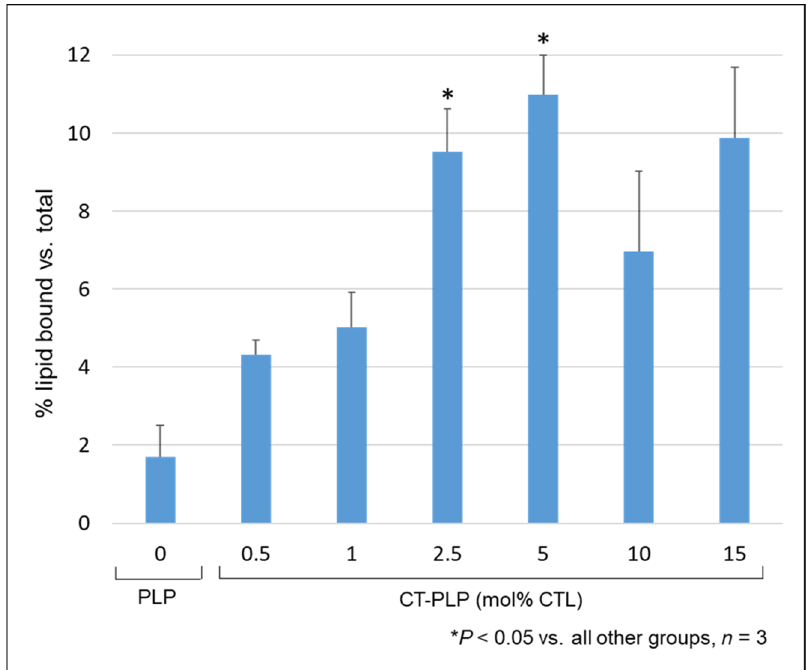
Figure 5. CTL incorporation increased liposomal collagen binding in a dose-dependent manner. The binding affinity of CT-PLPs assembled with 2.5 and 5 mol % CTL was significantly higher than in all other groups. Binding was detected by the fluorometry of Rho-labeled lipids, and data of the groups were presented as mean % lipid bound compared to respective total lipid serial dilution curves.